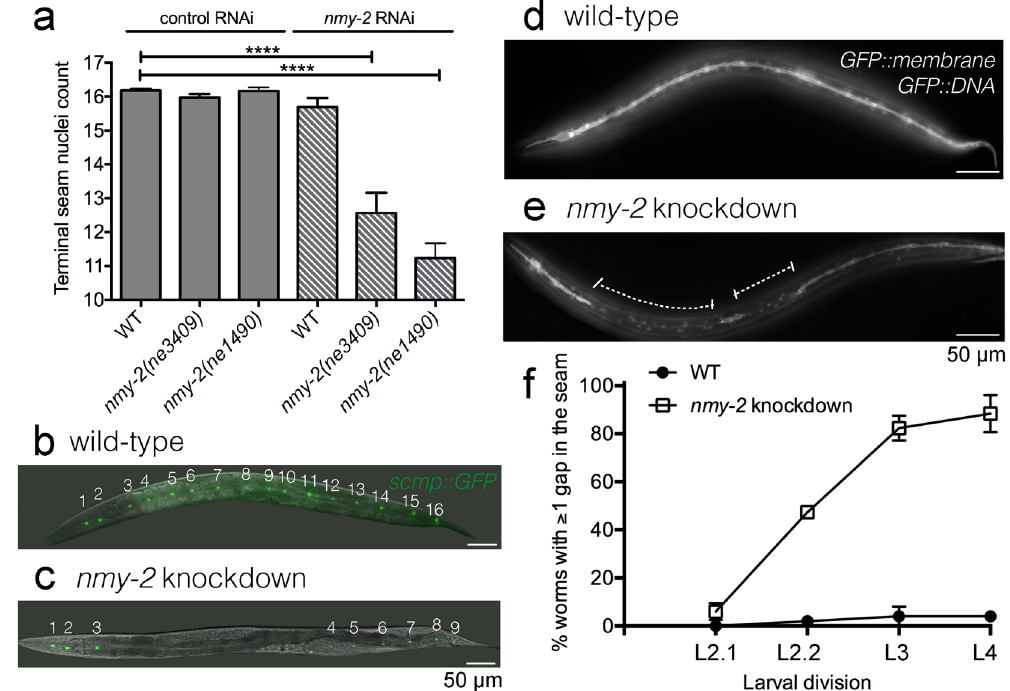
Figure 2. Post-embryonic nmy-2 knockdown results in progressive seam cell loss following asymmetric divisions. ( a ) Combining the ts allele with RNAi was necessary to achieve a decrease of terminal seam nuclei numbers. Synchronised L1 larvae (hatched from animals grown at 15 °C) with or without the nmy-2 ( ne3409 ) or nmy-2 ( ne1490 ) ts mutations (strains AW335, AW785 and AW786, respectively) were fed control or nmy-2 RNAi at 25 °C. Seam nuclei were counted in young adults using the integrated seam cell marker wIs51 [ scmp::gfp ]. The y -axis starts at 10 because the L1 larvae are born with 10 seam cells and gain additional seam cells through post-embryonic development. “WT” = wild-type. n > 50 for each sample. Error bars represent the standard error of the mean (SEM). Unpaired, two-tailed t -test was used to determine significance ( **** p < 0.0001). At least three independent replicates of the experiment were performed. Hashed pattern here and henceforth represents nmy-2 RNAi treatment. ( b , c ) Wild-type and nmy-2 knockdown adult hermaphrodites with the wIs51 seam cell marker. The wild-type animal showed 16 seam nuclei on one side, and the nmy-2 knockdown animal had 9. ( d , e ) Wild-type and nmy-2 knockdown adult hermaphrodites with the integrated membrane and DNA markers heIs63 [ wrt-2p::gfp::PH;wrt-2p::gfp::H2B ]. The wild-type animal showed a smooth and continuous seam syncytium, and the nmy-2 knockdown animal showed two gaps in the seam syncytium (dashed lines). ( f ) The percentage of worms with at least one gap in the seam was quantified for the control and nmy-2 knockdown conditions following each seam cell division from L2 onwards (strains SV1009 and AW788). L2.1 = L2 first (symmetric) division. L2.2 = L2 second (asymmetric) division. n > 50 per strain per stage. Two independent replicates of the experiment were